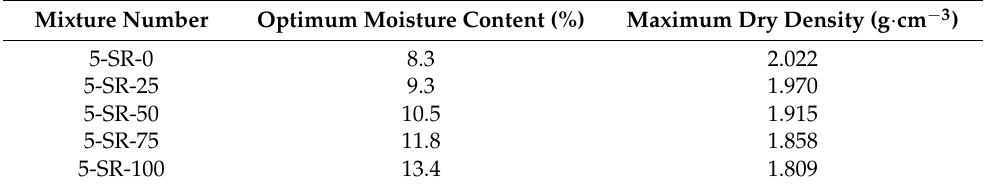
Table 5. Proportions of mixture parameters.